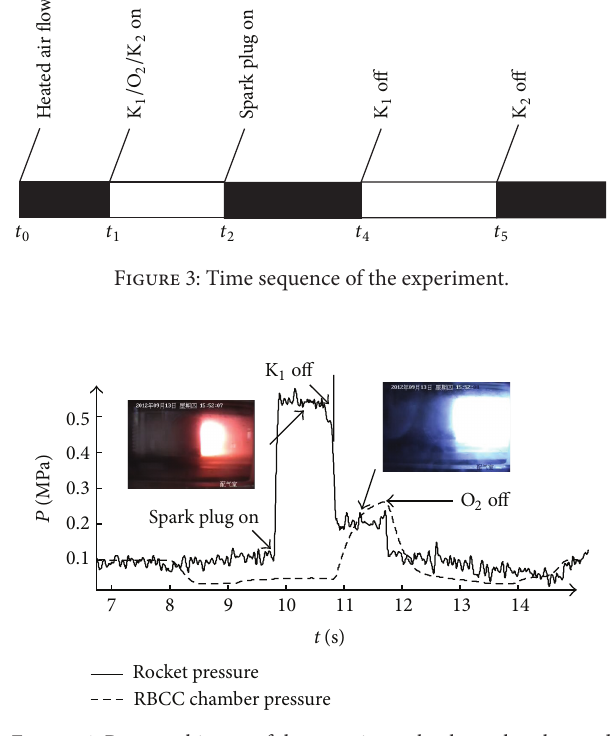
Figure 4: Pressure history of the strut-jet rocket base chamber and the RBCC combustor.